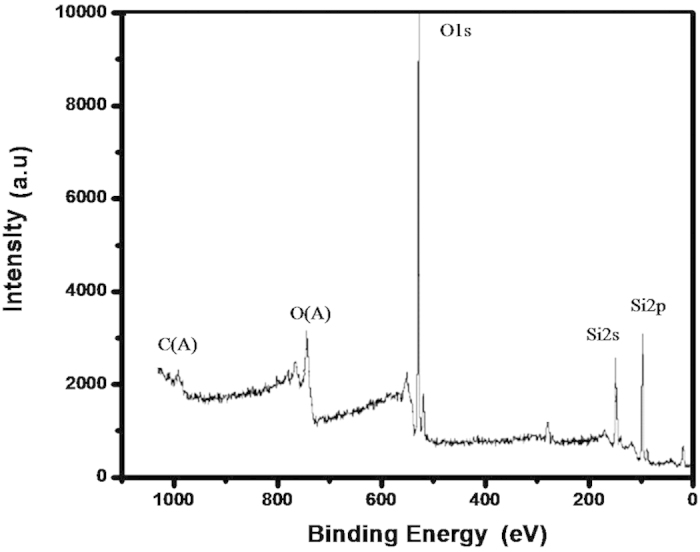
XPS spectra of SiO2.